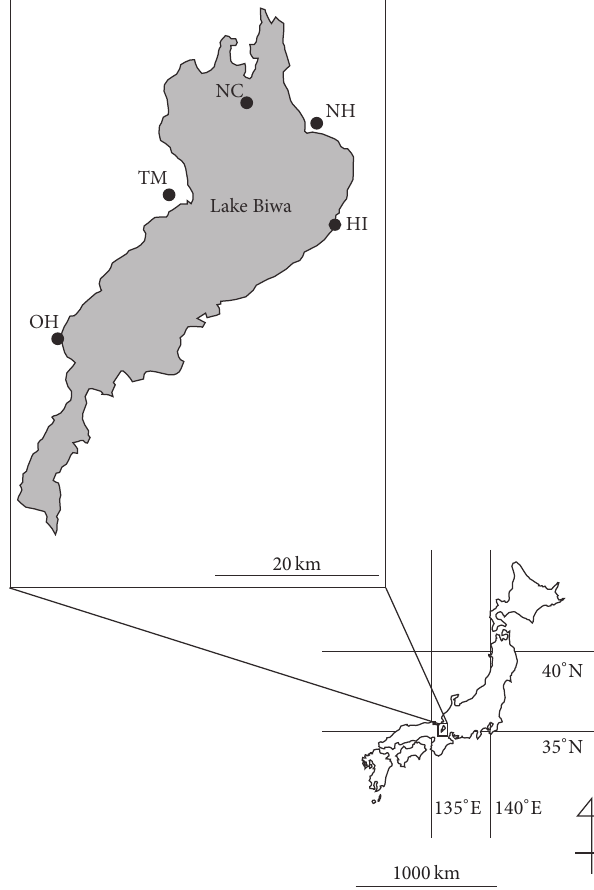
Figure 1: Location of the study sites around Lake Biwa,